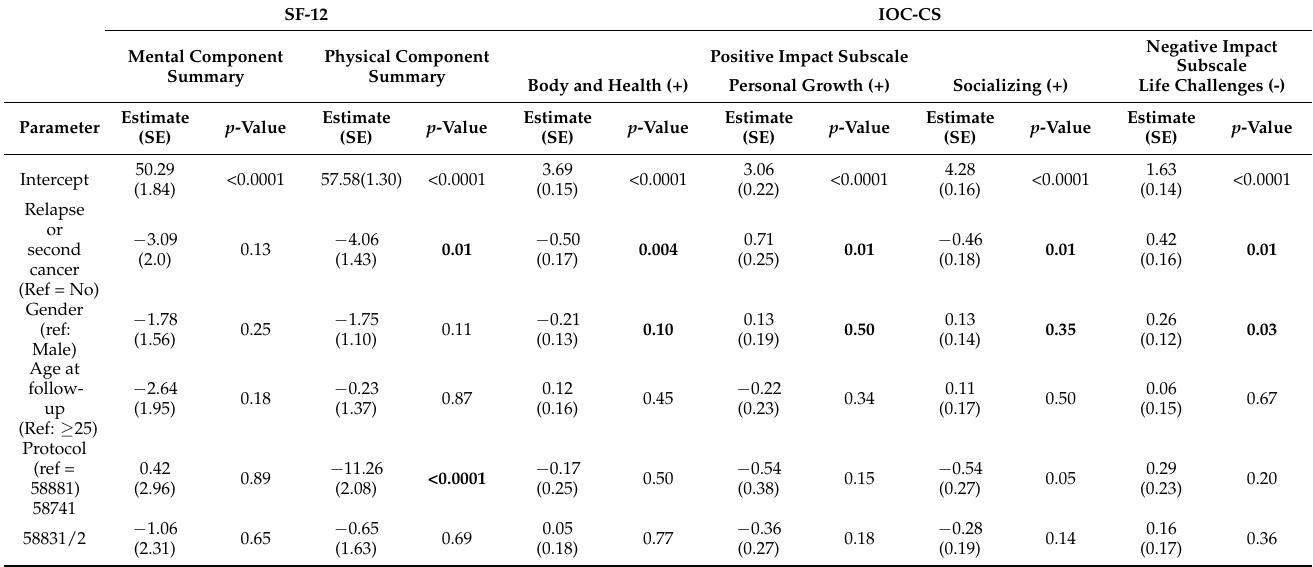
Table 4. Associations between relapse/second cancer status and SF-12 subscales and IOC-CS sub- scales based on a multivariable regression